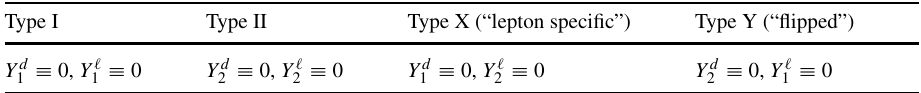
Table 2 Yukawa couplings in the four possible Z 2 symmetric THDM